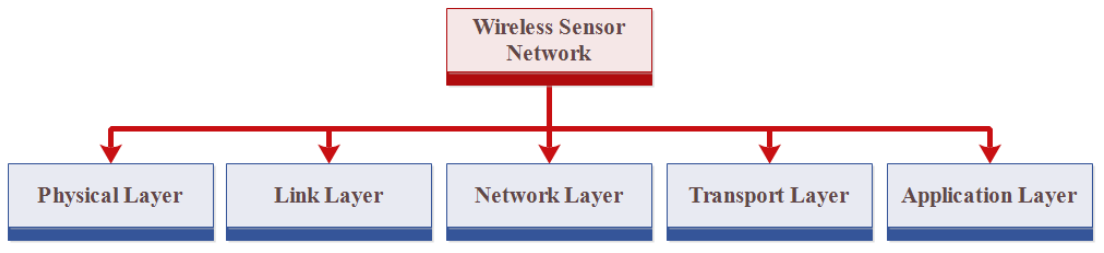
Figure 8. The layered architecture of a wireless sensor